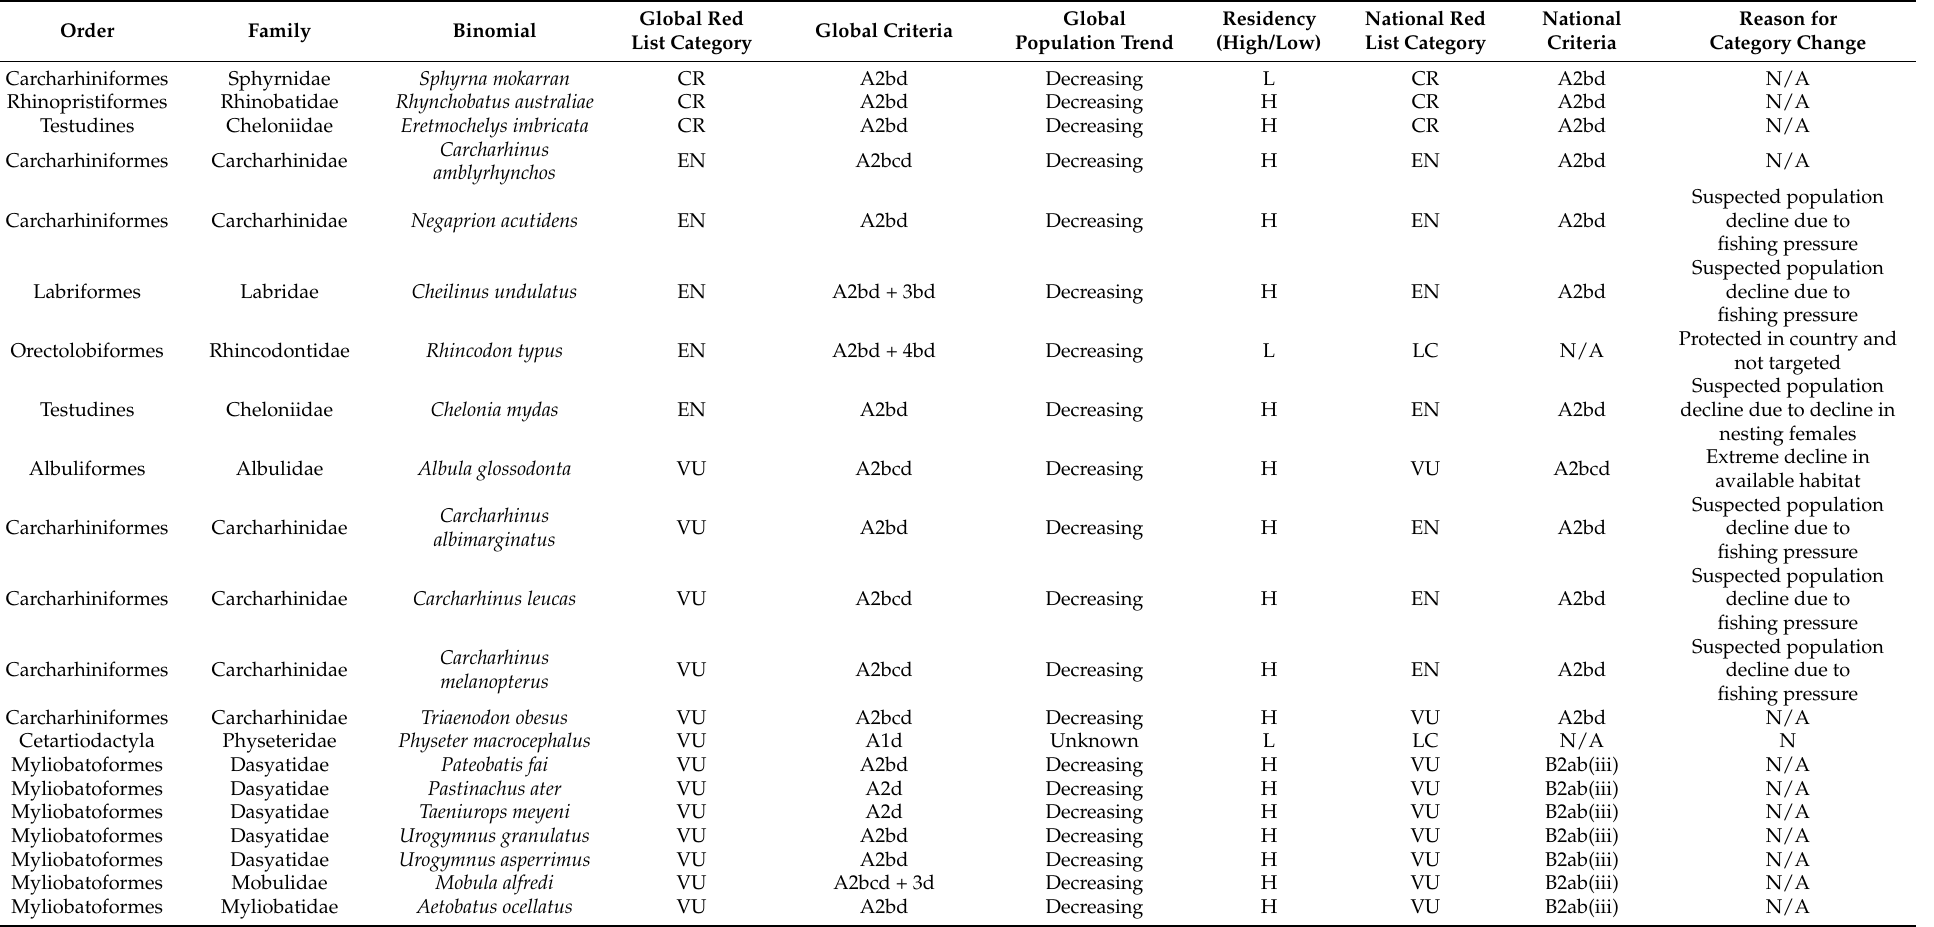
Table 1. List of ER species using the D’Arros and St Joseph site. Global Red List categories and criteria, as well as global population trend, were taken from current Red List assessments for each species. National Red List categories and criteria were based on theoretical national assessments conducted for each ER species, using IUCN guidelines and best available